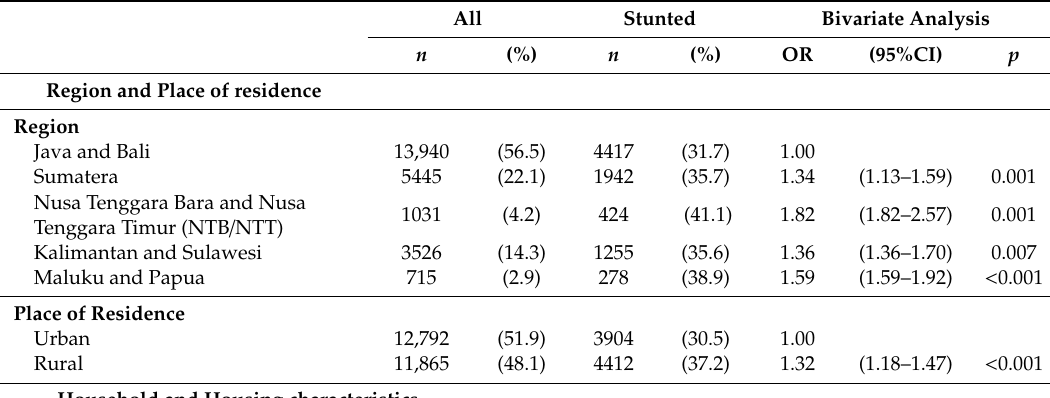
Table 1. Frequency distribution of respondents by di ff erent characteristics, The 2013 Indonesia Basic Health